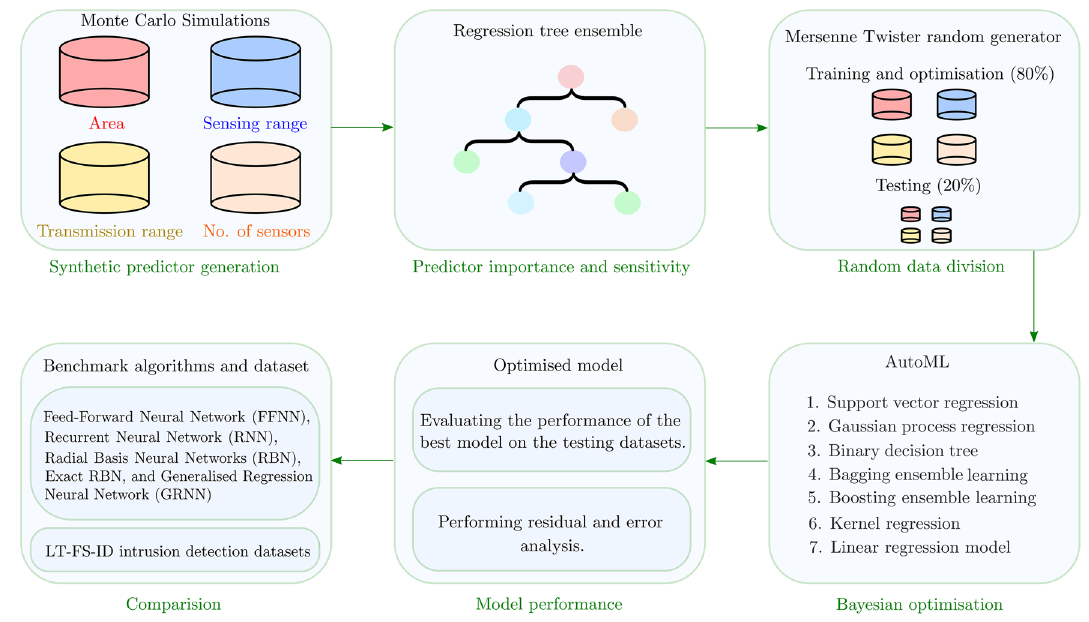
Figure 1. Flowchart of the proposed